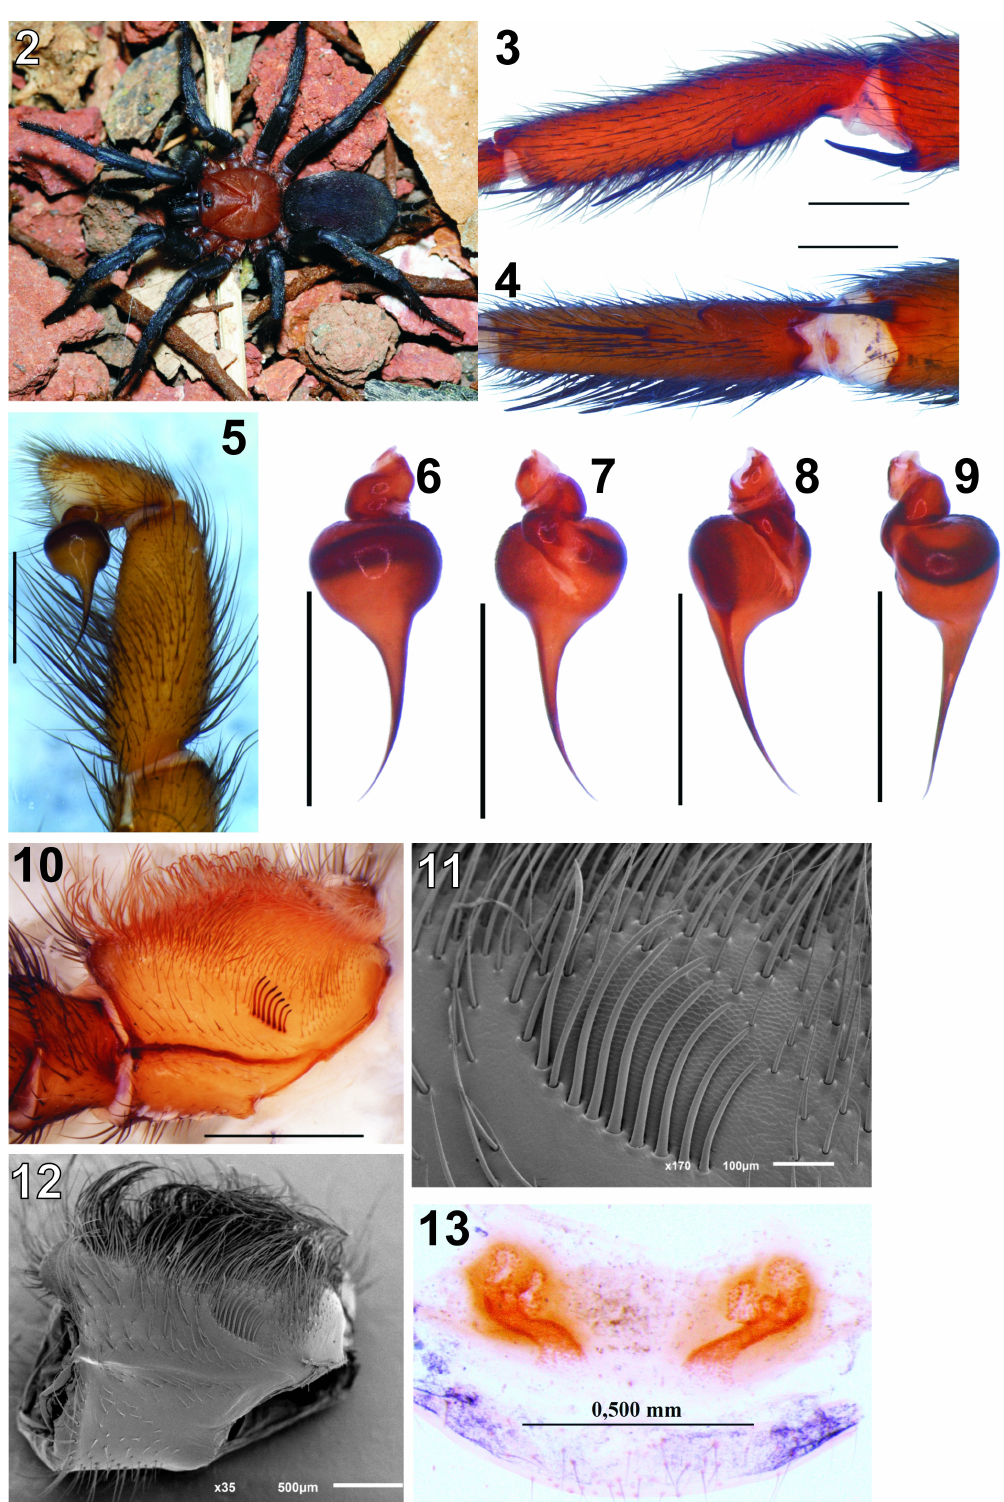
Figs 2–13. Diplura macrura (C.L. Koch, 1841). 2 . ♀, habitus dorsal. — 3–9 . ♂, left leg I. 3 . Tibial spur, retrolateral. 4 . Tibial spur and metatarsal clasper, ventral. 5 . Left palp, retrolateral. 6–9 . Left bulb. 6 . Retrolateral. 7 . Prolateral. 8 . Ventral. 9 . Dorsal. — 10–13 . ♀. 10 . Maxilla with lyra. 11 . Lyra detail, SeM. 12 . Maxilla with lyra, SeM. 13 . Vulva, dorsal. Scale = 1 mm, unless